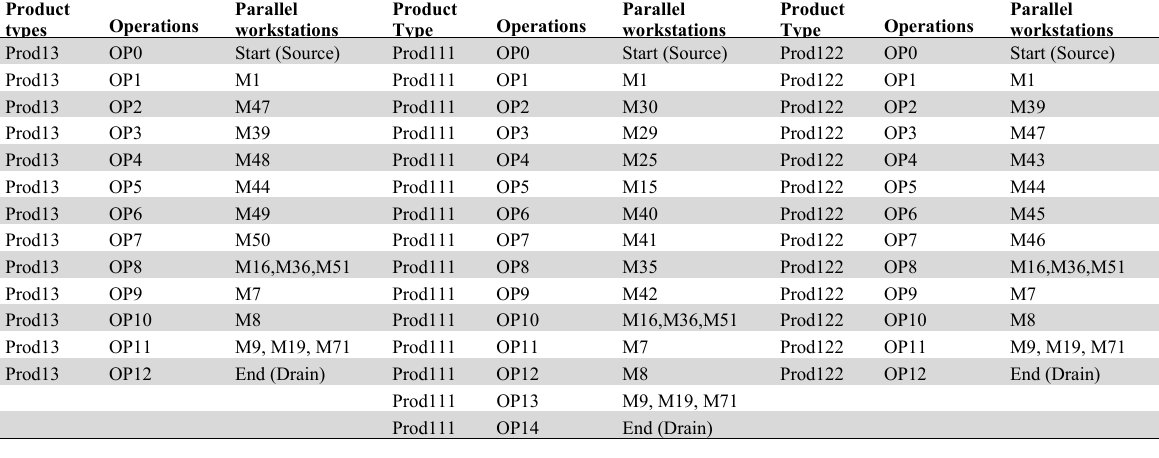
Illustrative process plans for product types